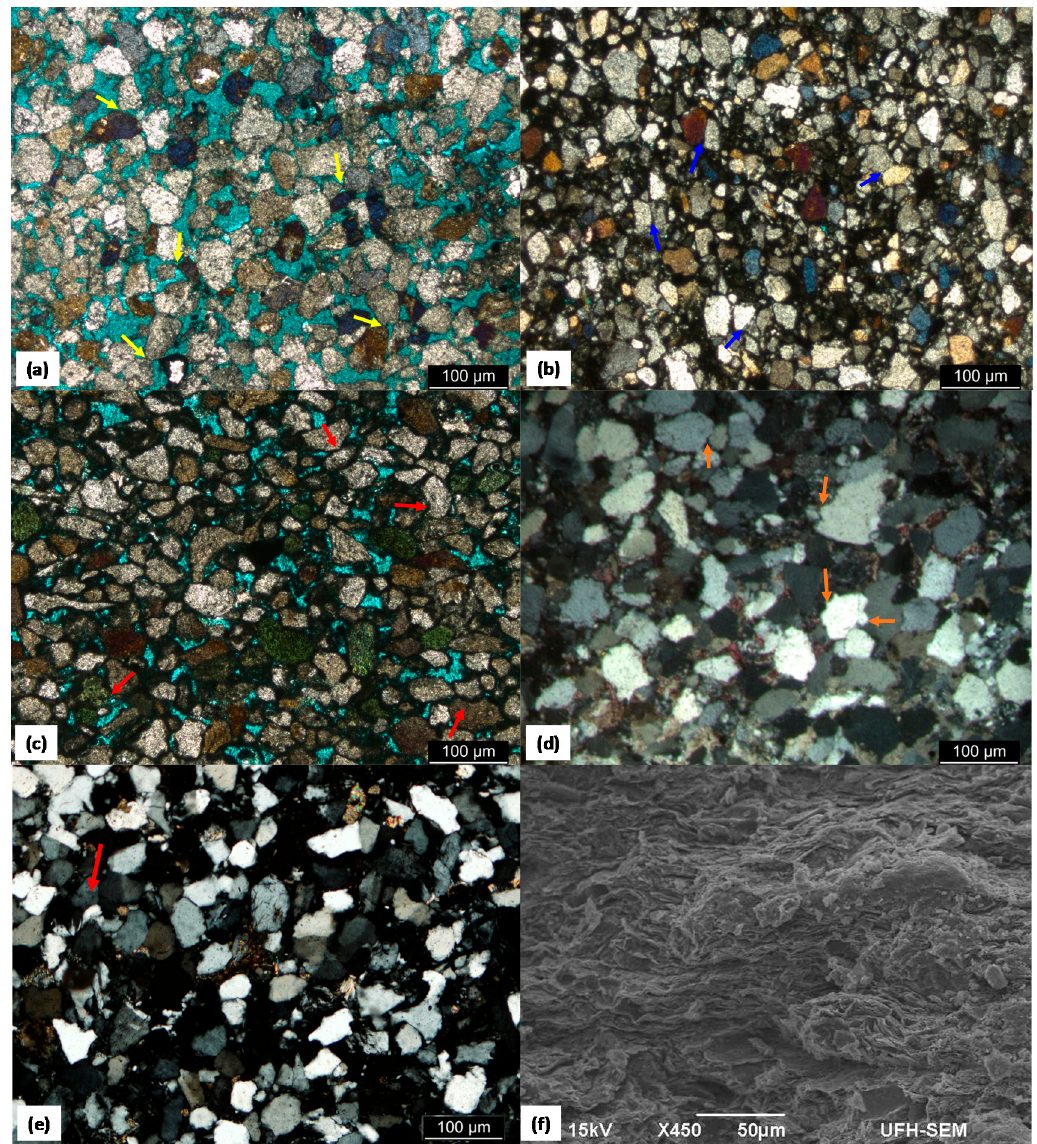
Figure 6. Thin section photomicrograph of sandstone showing different grain to grain contact patterns due to increasing burial depth: ( a ) Point contact (yellow arrows); ( b ) Long contacts (blue arrows); ( c ) Convano-convex contacts (red arrows); ( d ) Sutured contacts (brown arrows); ( e ) Grain deformation; ( f ) Grain alignment and deformation: SEM (BSE) photomicrograph showing orientation and deformation of clays as a result of compaction.